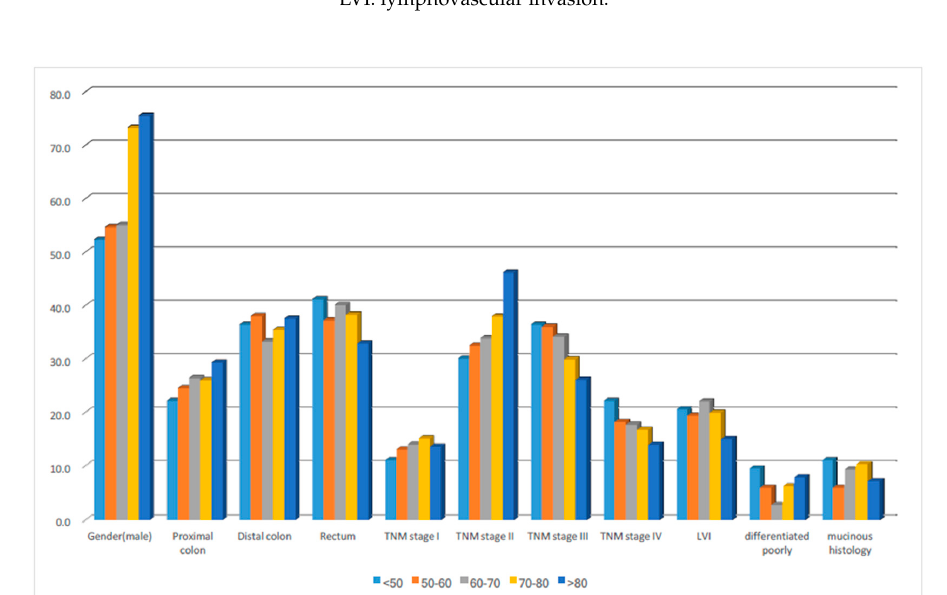
Figure 1. The clinicopathological distributions in different age groups of colorectal cancer patients. Table 2. Number and frequency of molecular alterations in different age groups of CRC